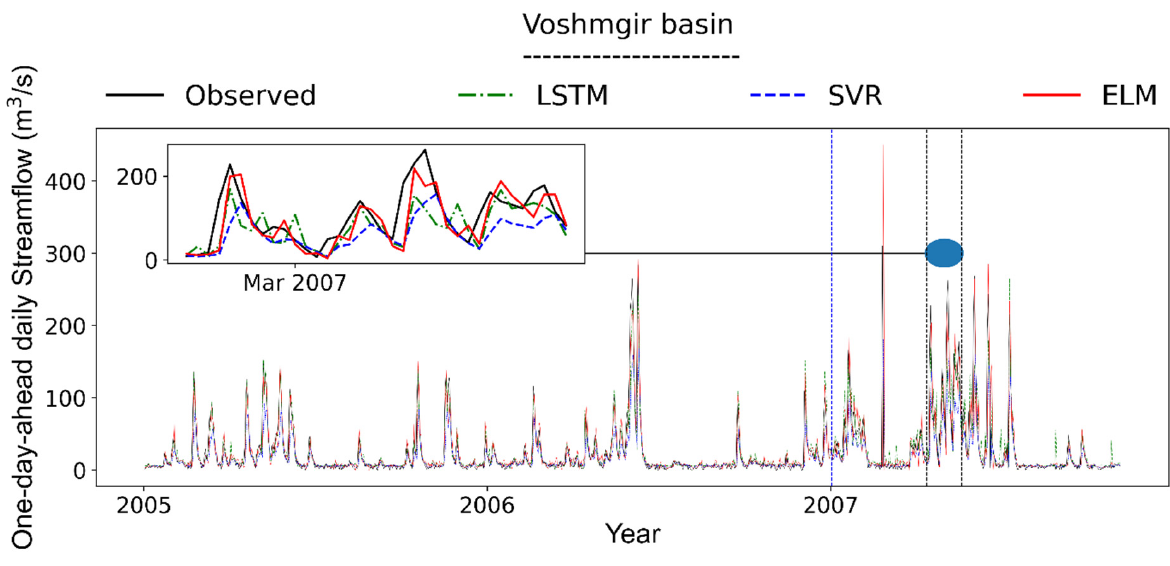
Figure 7. Comparison of forecasting and observed daily streamflow for one-day prediction during the calibration and validation periods using ML models. The blue vertical dashed line divides the time series into calibration and validation periods. A zoom-in of the blue circle area investigates the model’s performance in March 2007.